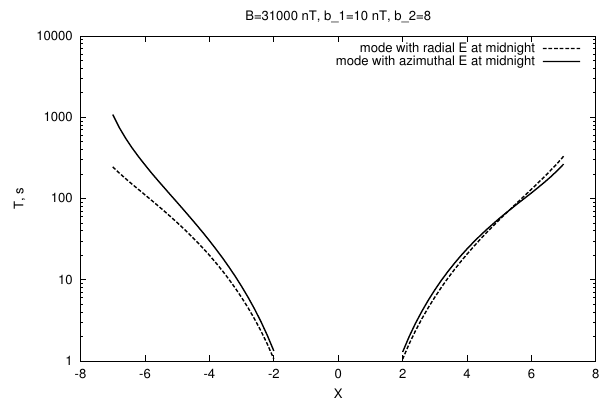
Fig. 4. Periods of the two Alfv´en wave modes along noon-midnight line. Positive X is towards the Sun.